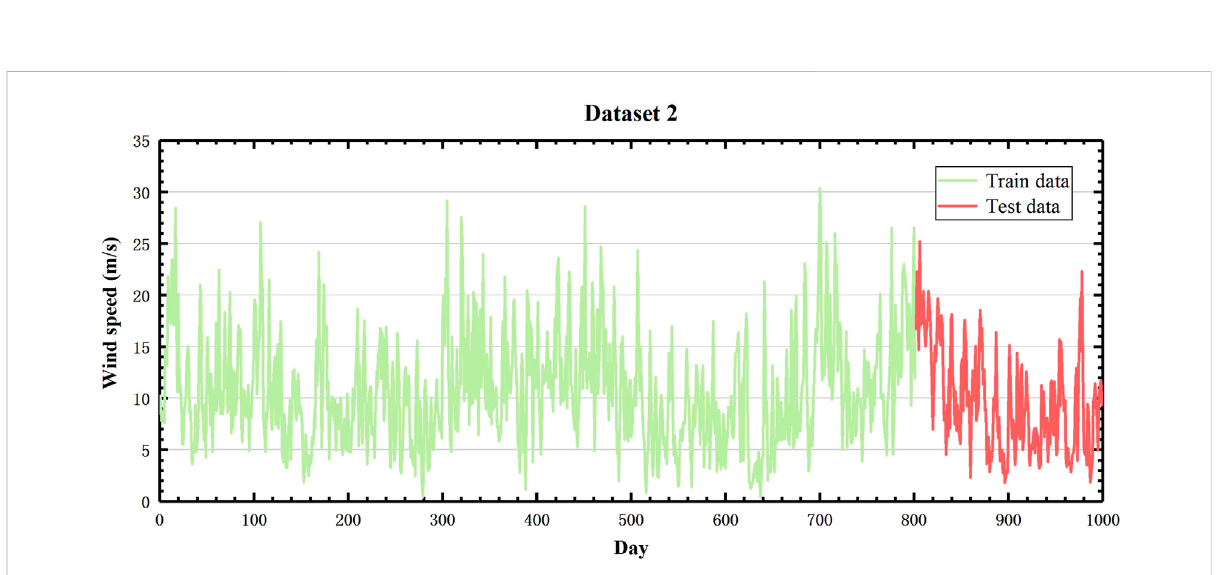
FIGURE 3 Original wind speed dataset